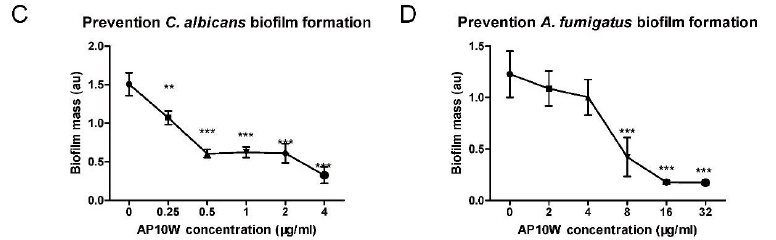
Figure 2. Growth inhibition of C. albicans and A. fumigatus biofilms by AP10W. ( A ) Microscope biofilm images of C. albicans incubated with different concentrations of AP10W (0 − 2 × MFC). Scale bars: 200 μm. ( B ) Microscope biofilm images of A. fumigatus incubated with different concentrations of AP10W (0 − 2 × MFC). Scale bars: 500 μm. ( C ) Inhibition of C. albicans biofilm formation by AP10W. ( D ) Inhibition of A. fumigatus biofilm formation by AP10W. Results are expressed as the biofilm mass, measured using crystal violet staining, in arbitrary units (au). Data are shown as means ± SD (n = 5) from three independent experiments. ** p < 0.01, *** p < 0.001.